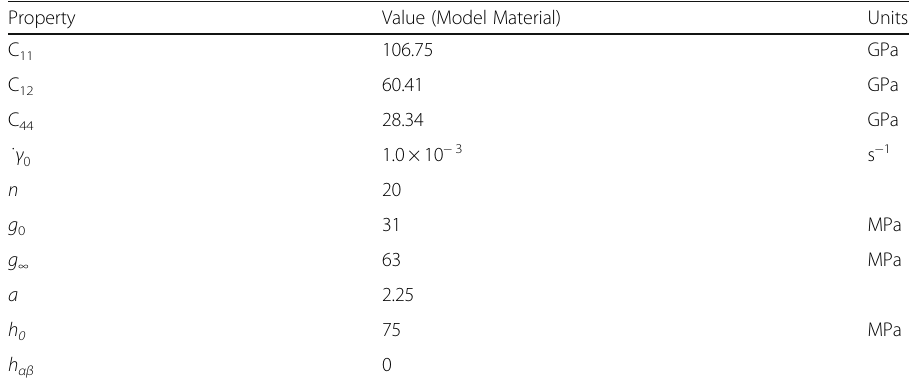
Table 1 Phase parameters used in the simulations for the model material (Tikhovskiy et al. 2007)